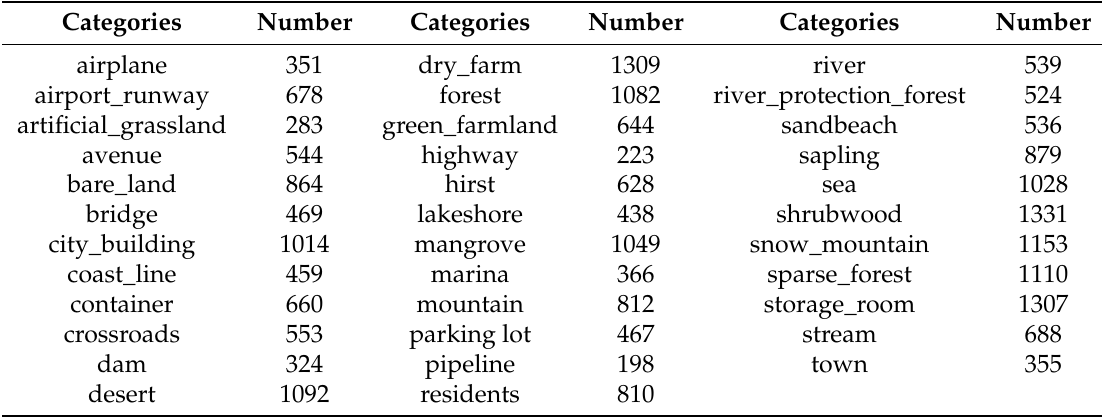
Table 4. Different sub-classes and the number of images in